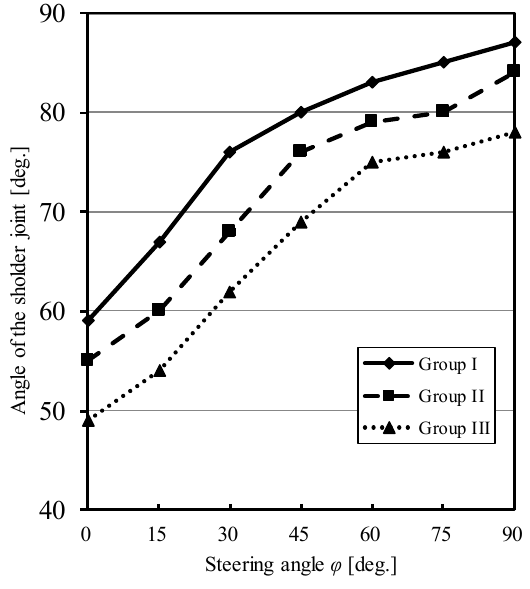
Figure 5. Relationship between height and arm length.